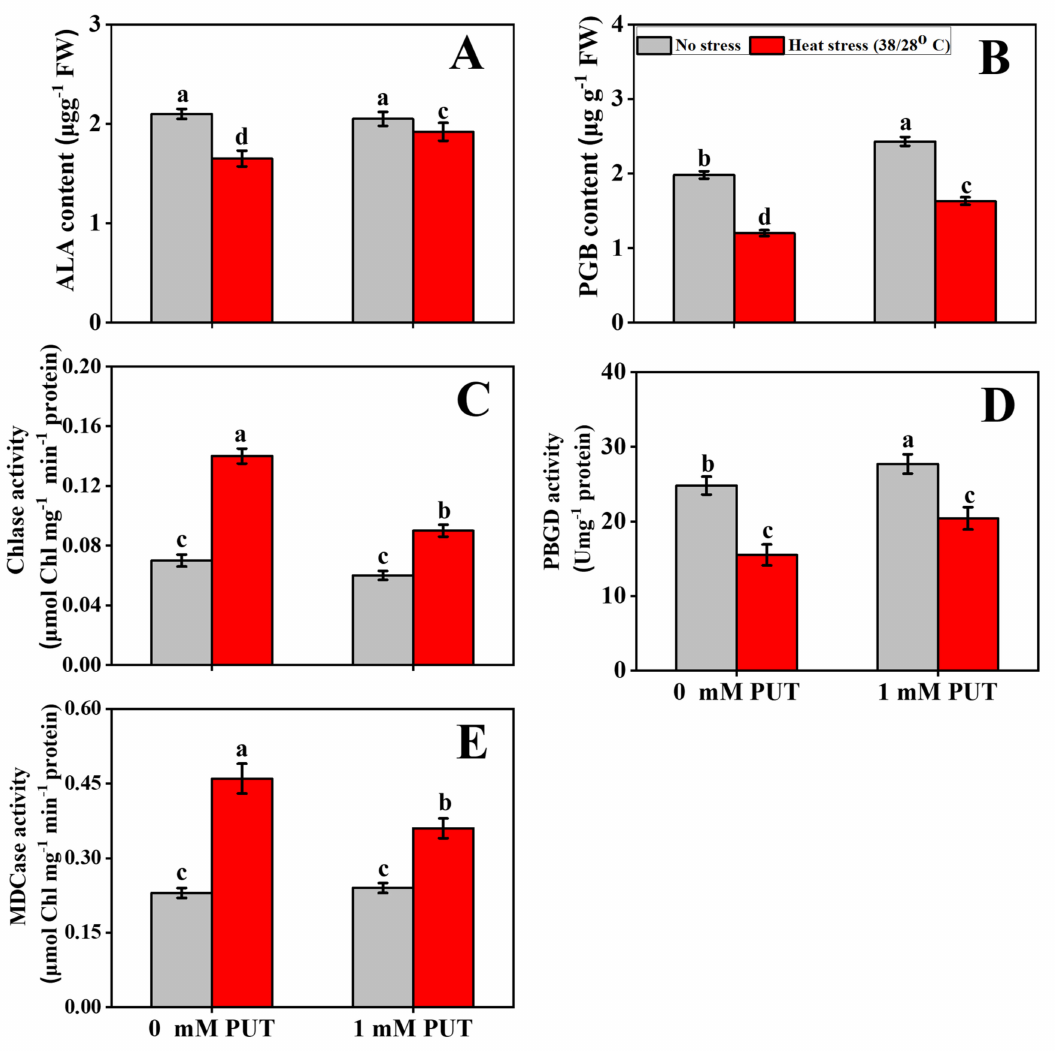
Figure 2. Interactive effects of Putrescine and high temperature on ( A ) δ -Aminolevulinic acid (ALA) content, ( B ) Porphobilinogen (PBG) content, ( C ) Chlorophyllase (Chlase) activity, ( D ) Porphobilinogen deaminase (PBGD) activity, and ( E ) Mg-dechelatase (MDCase) activity in tomato seedlings. The data denote the mean value ± standard error (n = 3). Different alphabetic letters represent the significant differences among the treatments at p < 0.05, according to Tukey’s